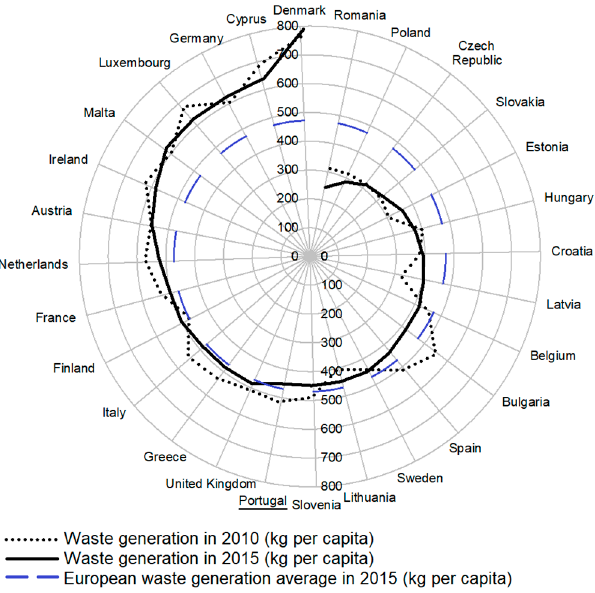
Figure 1. MSW generated per person in 28 European countries (2010 and 2015).